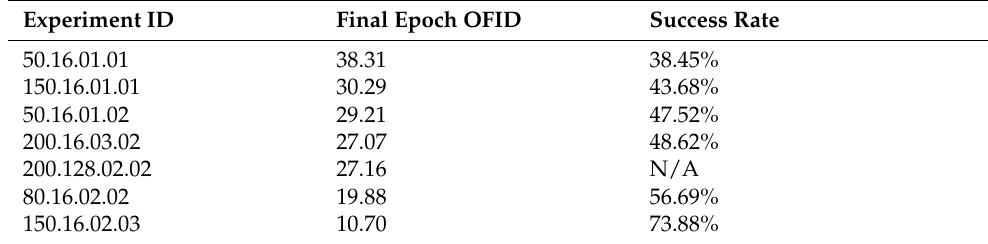
Table 2. Success metrics of the various